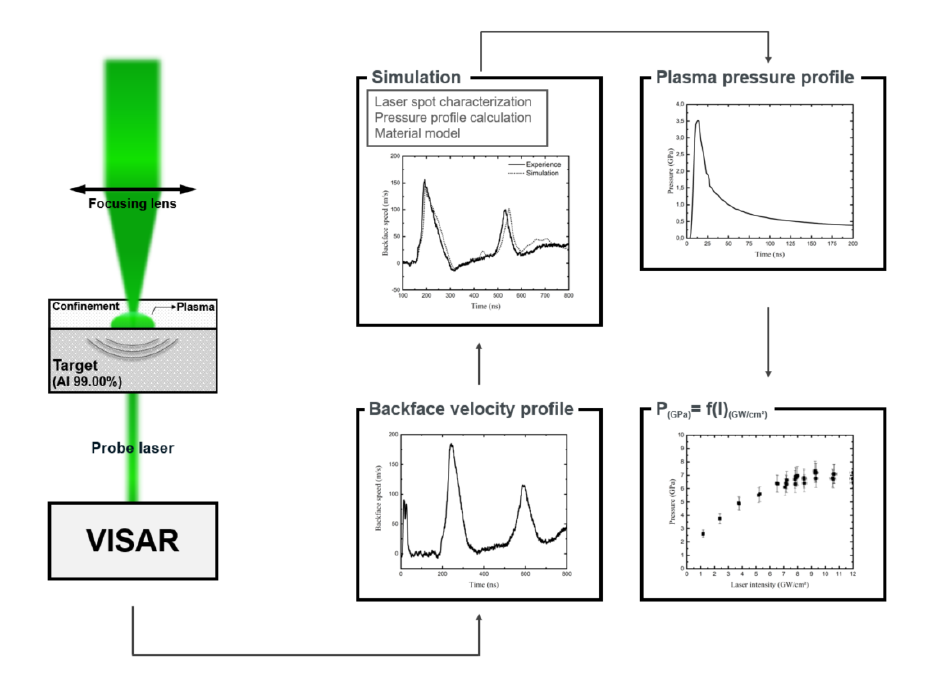
Figure 1. Setup used to calculate pressure from the backface velocity